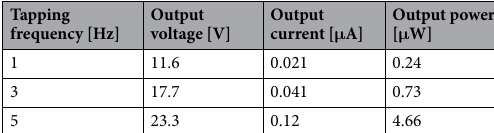
Tapping frequency